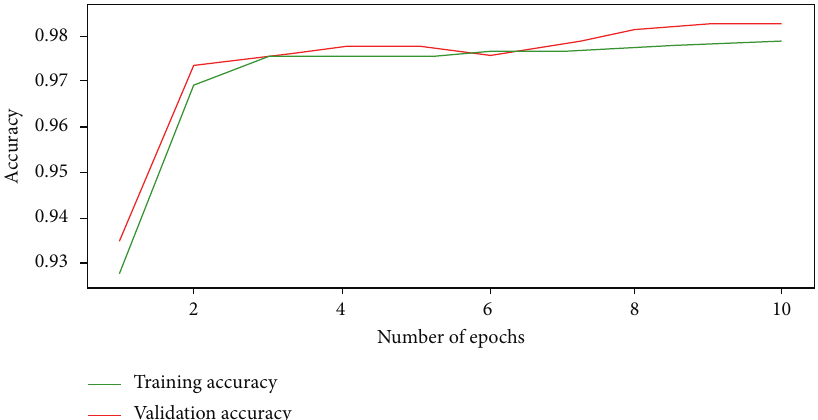
Figure 15: Performance of the proposed models: (a) convolution neural network (CNN) model and (b) long short-term memory (LSTM) model.